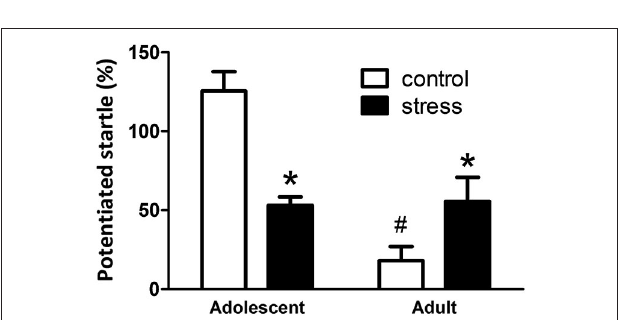
FIGURE 2 | Effects of stress on the performance of fear-potentiated startle task in adolescent and adult rats. The same fear-potentiated startle task was used to test the amygdala-related learning and memory in adolescent and adult rats. * Significantly different between control and stress groups; # significantly different between adolescent control and adult control groups, two-way ANOVA followed by Bonferroni’s post hoc test.